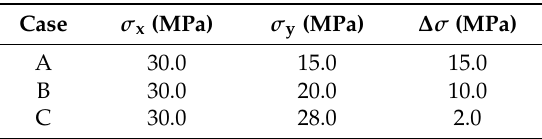
Table 3. Stress magnitude in cases A, B and